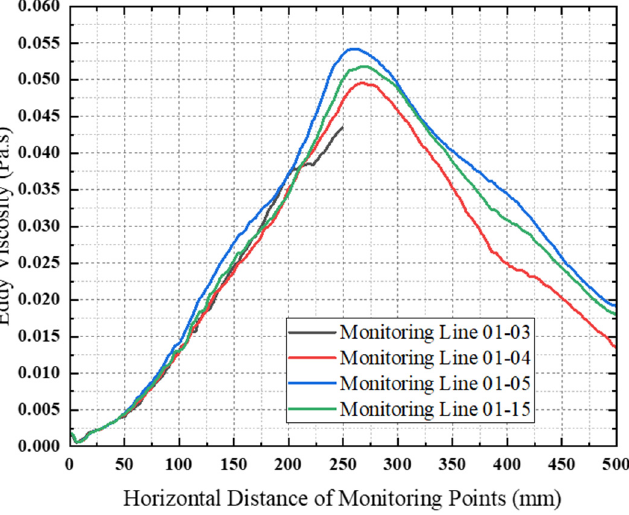
Figure 11. Line chart of the eddy viscosity of the standard nozzle flow field with a compressed air pressure of 212,782 Pa and a temperature of 303